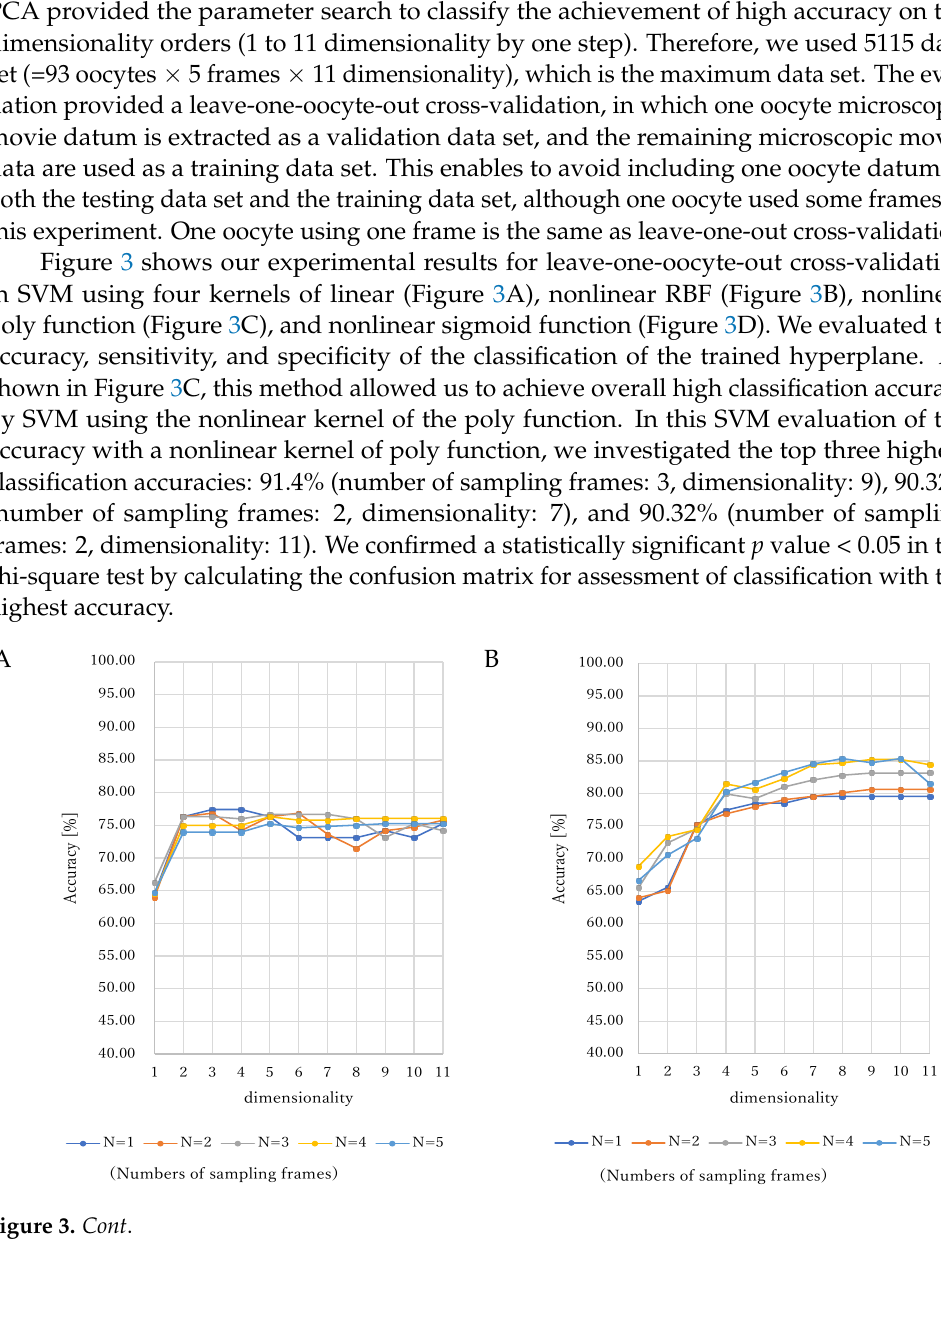
Figure 3. Evaluation results of SVM using four kernels of linear, nonlinear RBF, nonlinear poly func- tion, and nonlinear sigmoid function. Table 1 shows the classification accuracy, sensitivity, and specificity of two cases of two and three sampling frames in nonlinear poly function SVM. A larger dimensionality was confirmed to lead to higher performance of accuracy. Table 2 shows the mean and standard deviation (SD) of the classification accuracy by sampling frames, and the amount of change indicates the value compared with the smaller value of the sampling frames. Table 3 shows the mean and SD of the classification accuracy by dimensionality in the feature vector of SVM, and the amount of change indicates the value compared with one smaller value for the sampling frames. Table 1. Classification accuracy in nonlinear kernel of polynomial function in SVM a. Sampling frames Dimensionality